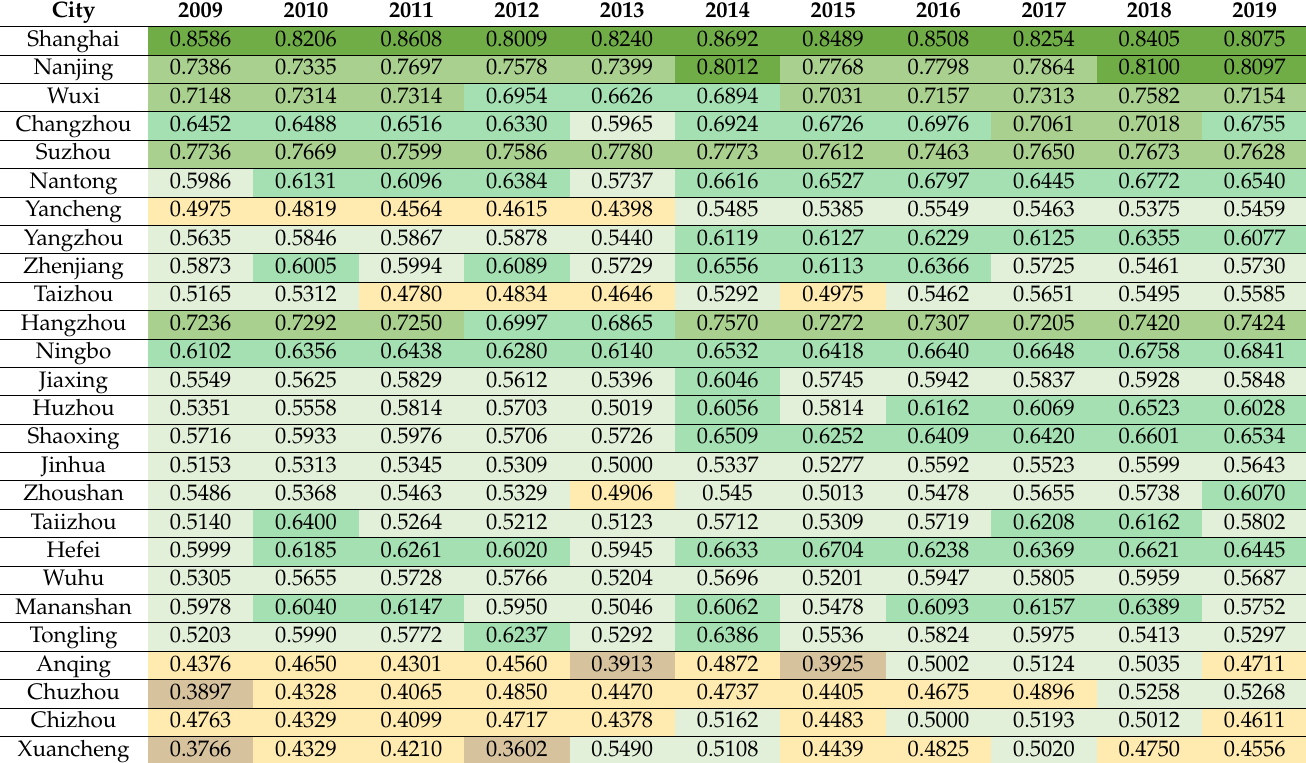
Table 6. Coordination between ED and EE in the YUA from 2009 to